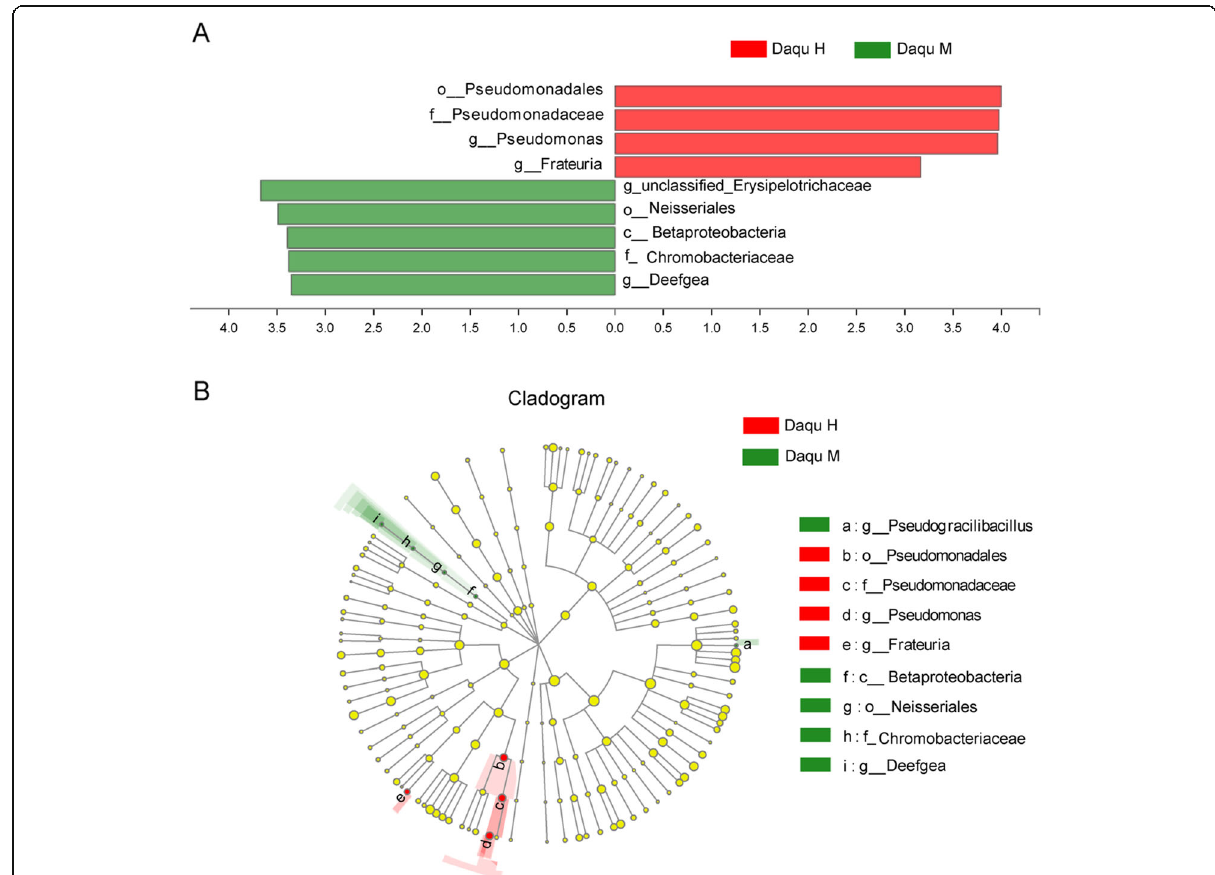
Fig. 5 Key phyla of bacteria in Daqu H and Daqu M samples during incubation, as determined by LEfSe. a Indicator bacterial groups with LDA values higher than 2.0 within the two types of Daqu. b Cladogram indicating the phylogenetic distribution of microbial species associated with the two types of